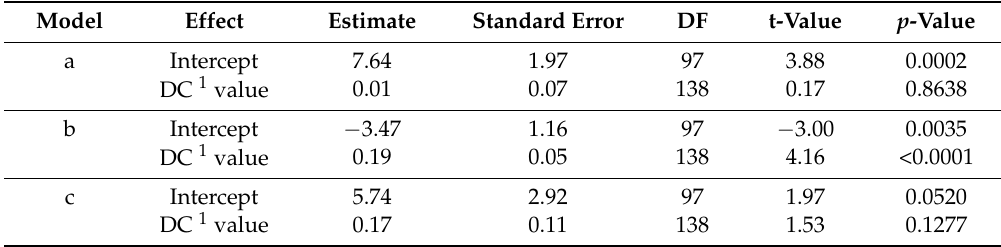
Table 2. Results of the three models (a: score = 1 versus score ≥ 2; b: score ≤ 2 versus score ≥ 3; c: score ≤ 3 versus score = 4) within the generalized linear model approach for the tested effects including the estimate, the standard error, the degree of freedom (DF), the t-value, and the p -value.